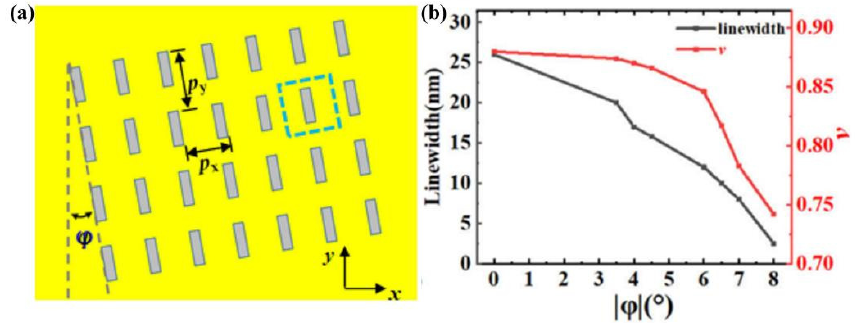
Figure 3. ( a ) Schematic and geometrical parameters of a tilted metallic nano–groove antenna array. Adapted with permission from Ref. [70]. Copyright (2021), Optical Society of America. ( b ) Linewidth Fano resonance versus φ .